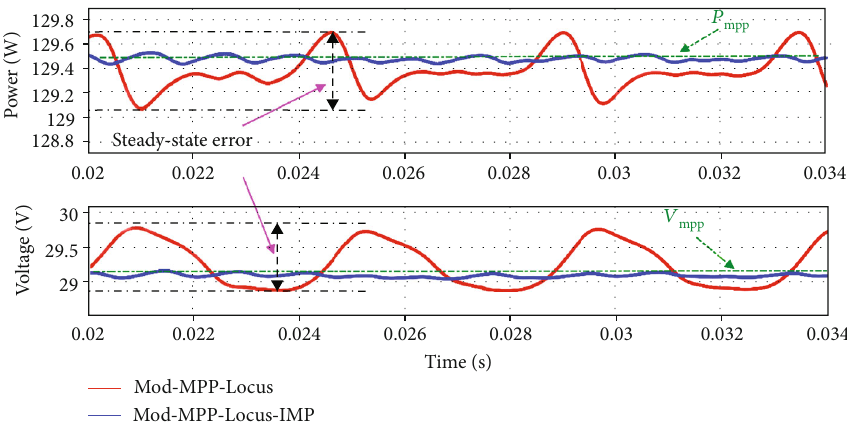
Figure 26: Comparison of the voltage and power in the steady state at G = 600W/m 2 and T = 25 ° C